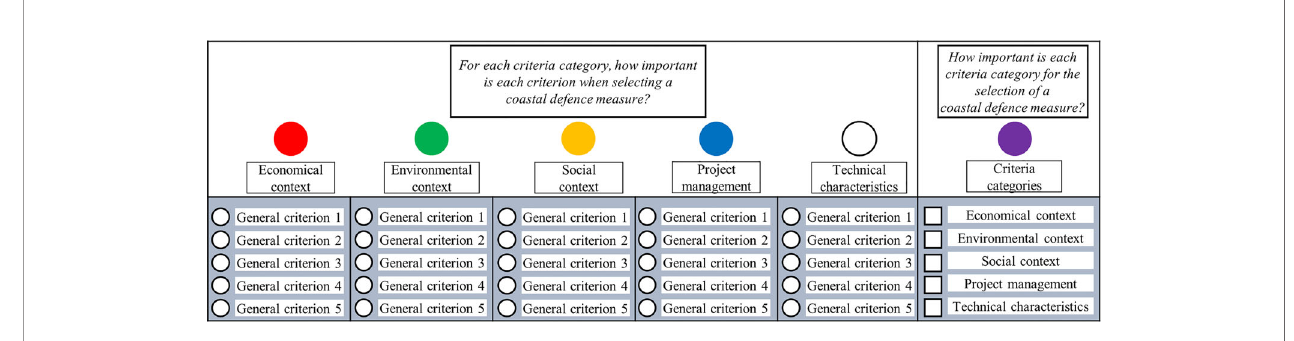
FIGURE 5 | Voting table